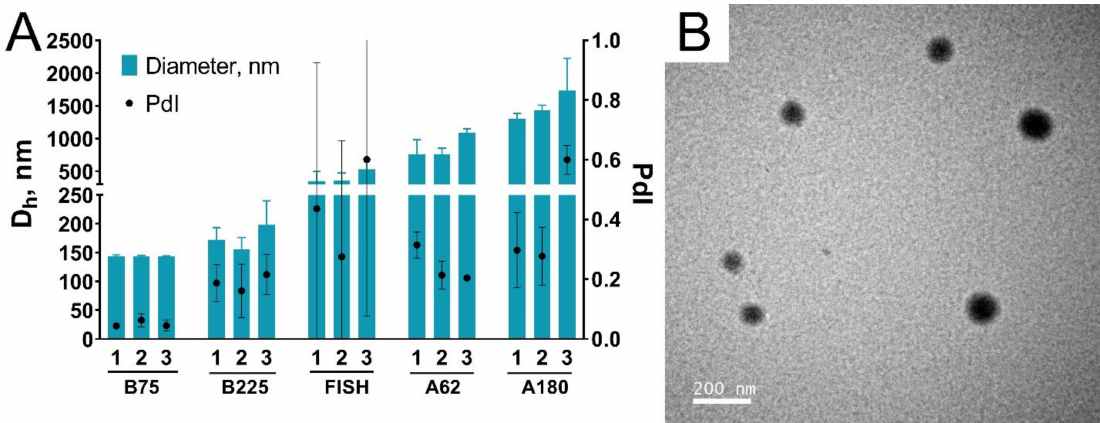
Figure 9. Size of gelatin nanoparticles loaded with fluorescent europium complexes ( A ) and TEM image of europium-loaded nanoparticles prepared from gelatin B 75 bloom ( B ). Dh—hydrodynamic diameter; PdI—polydispersity index. Mean values of three technical replicates are shown, mean ± SD. The scale bar is 200